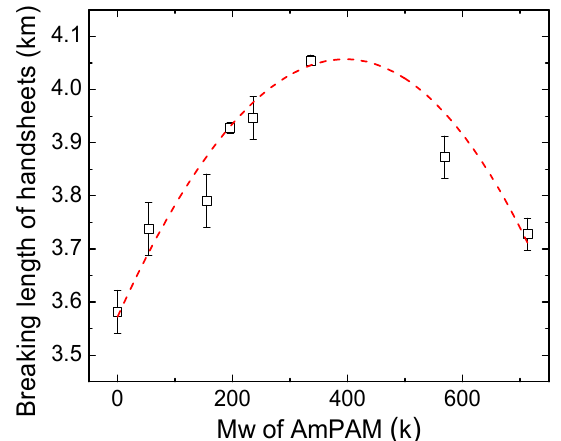
Figure 1. Breaking length of paper treated with amphoteric polyacrylamide (AmPAM) of various molecular weights (MWs) at 0.5 wt.% (on o.d. fiber). Polynomial regression with order 3 was presented as a red, dashed line.